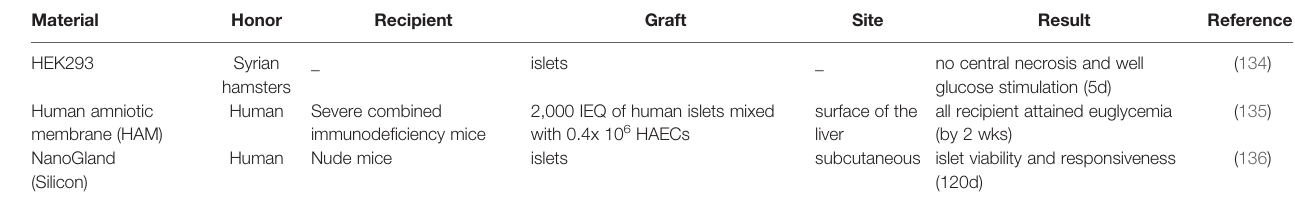
TABLE 2 | Non-hydrogels as biomaterials for cell encapsulation.